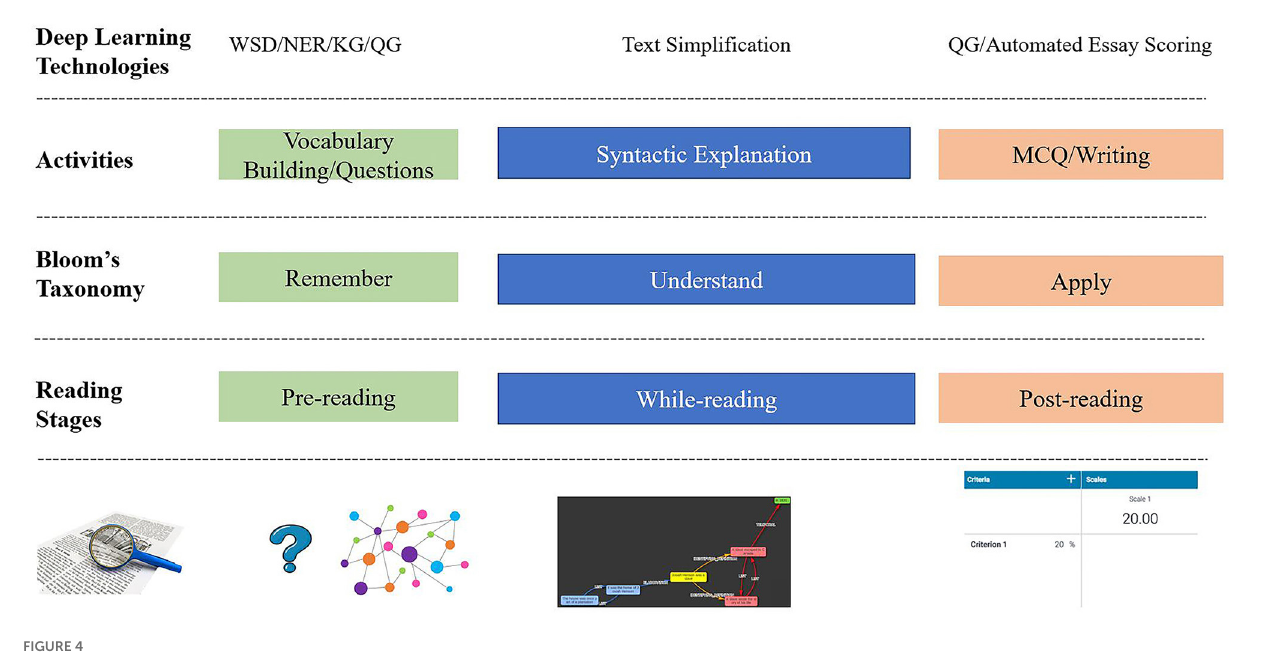
FIGURE4 Mappings between reading stages and deep-learning